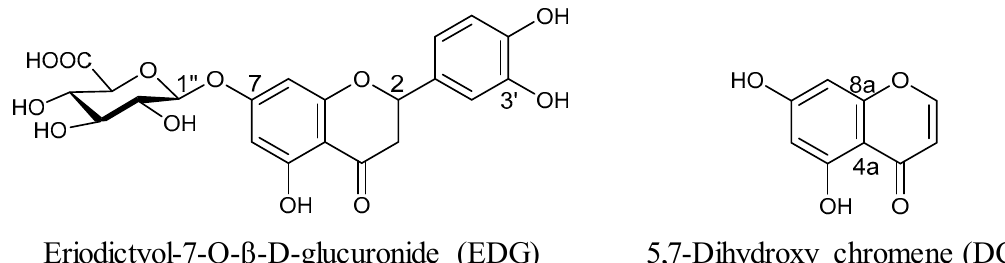
Figure 1. Chemical structures of ( left ) eriodictyol-7- O - β - D -glucuronide (EDG) and ( right ) 5,7-dihydroxy-4-chromene (DC) isolated from Chrysanthemum zawadskii var. latilobum (CZL) .